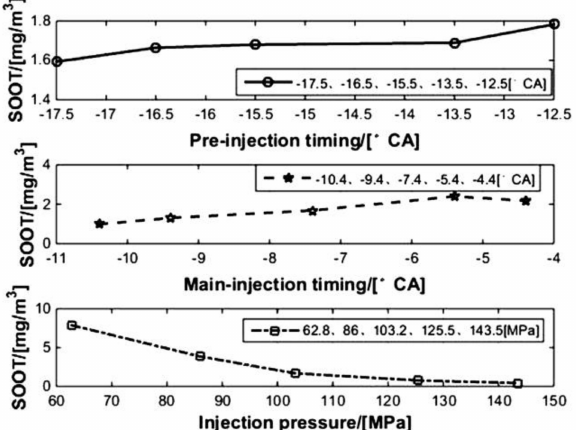
Figure 7. Effects of different injection parameters on soot